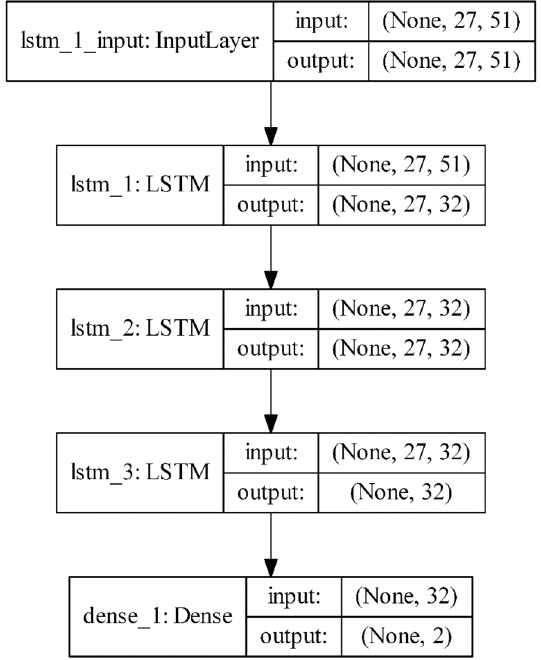
Figure 5. LSTM model structure.